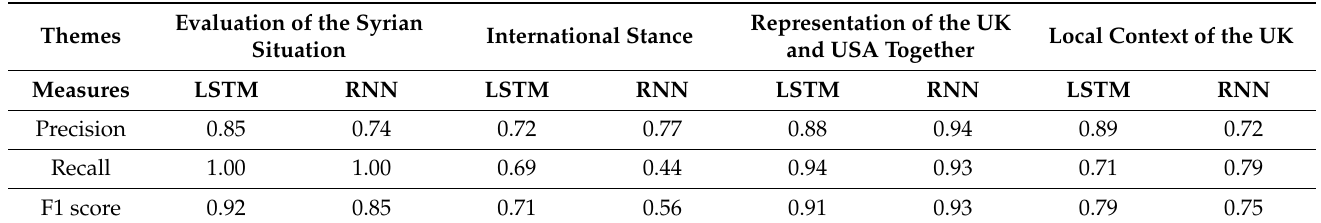
Table 5. Results of the text automatic thematic analysis over four themes using LSTM and RNN.